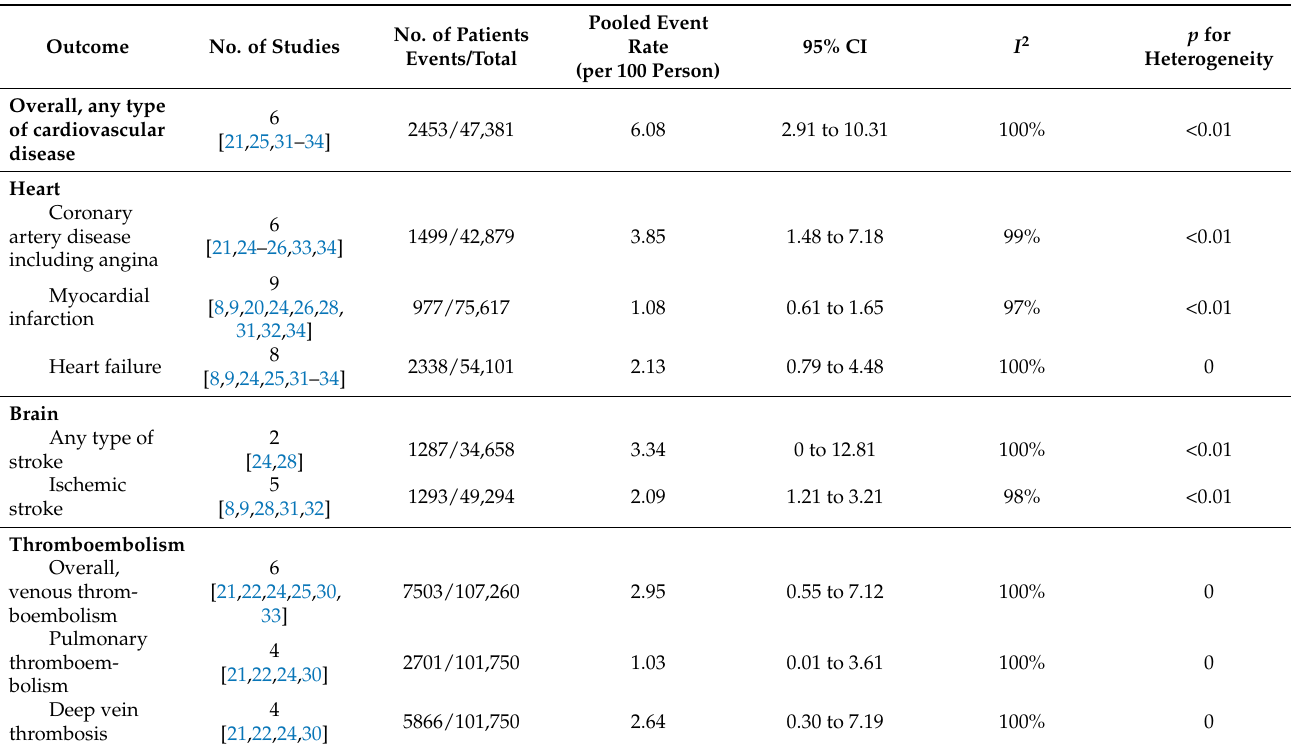
Table 2. Prevalence of various cardiovascular outcomes in patients with breast cancer with